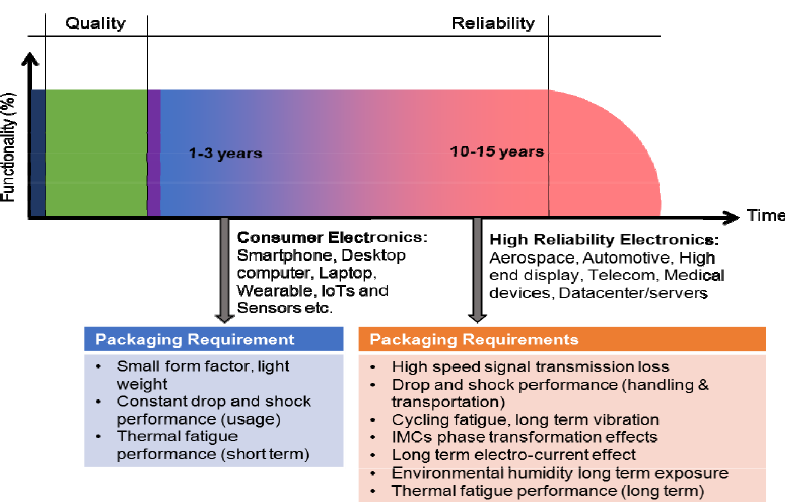
Figure 11. Quality and reliability considerations for consumer electronics and high